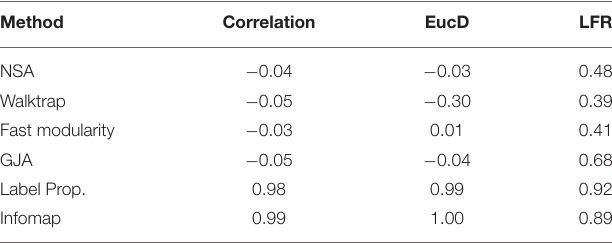
TABLE 4 | Modularity Ratio as an Indication of Accurate Community Assignments.